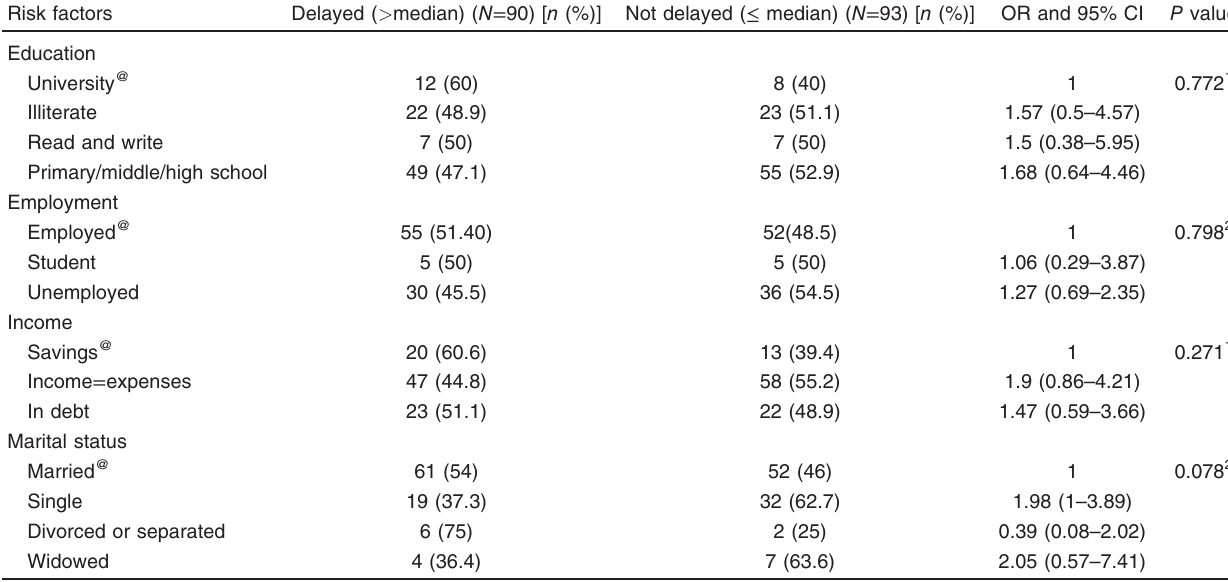
Table 9 Risk factors for total delay among studied patients (education, occupation, income, and marital status) ( N = 183) Risk